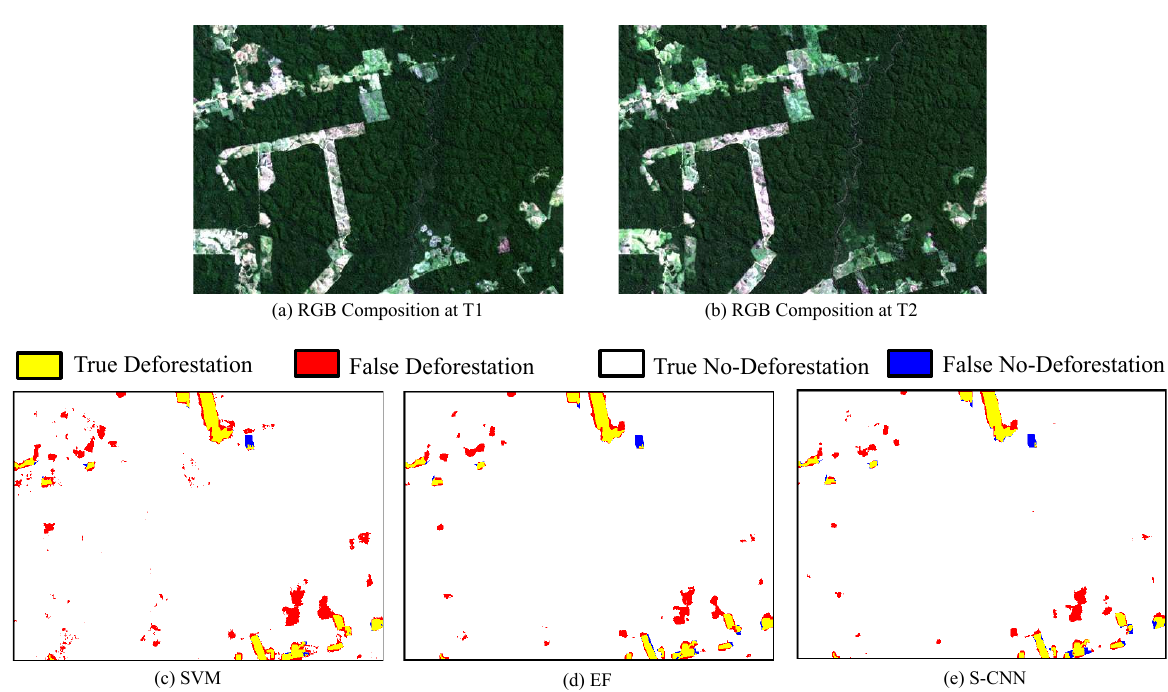
Figure 7. RGB composition and the change maps predicted by SVM, EF and S-CNN on the tile number two, which is part of the test region.